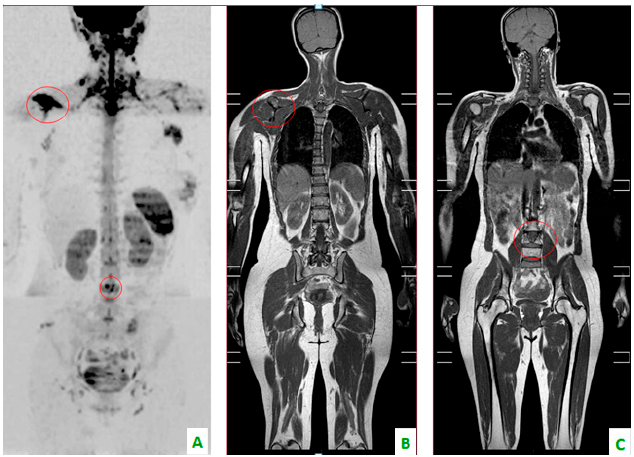
Figure 2. Bone localizations of breast cancer in the coronal plane: scapula and vertebral metastases (in the red circles). ( A ) DWI with a “positron emission tomography (PET)-like” view. The right scapula and one lumbar vertebra present an alteration of diffusivity. ( B ) T1 DIXON showing the hypointensity of the scapula and ( C ) lumbar soma.